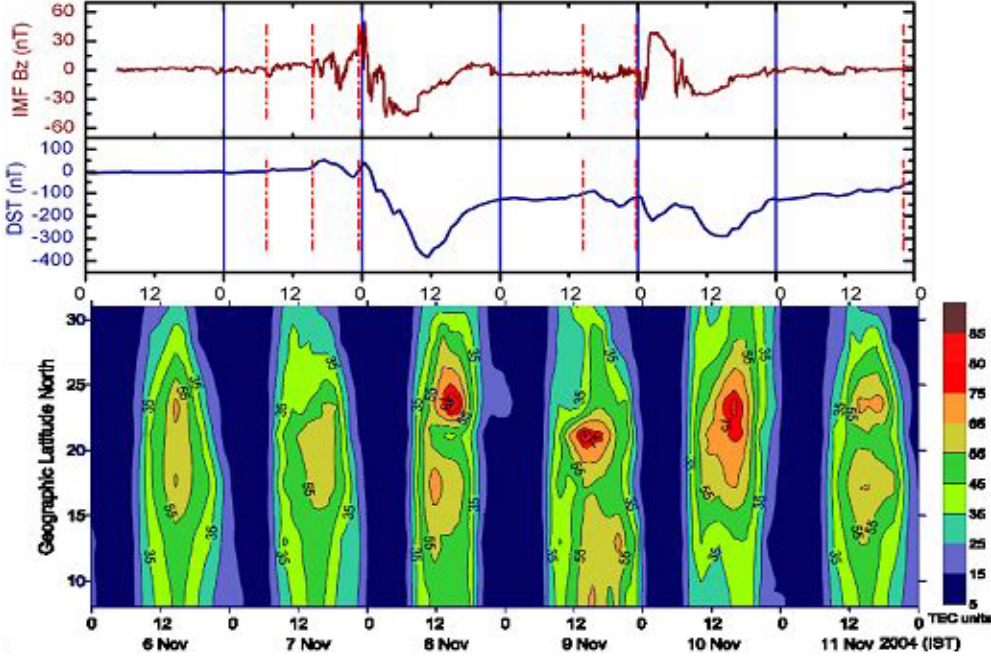
Fig. 3. TEC contour maps showing the formation of EIA crests, drawn as a function of latitude and time for the period from 6 to 11 November 2004 along with IMF B z and D st